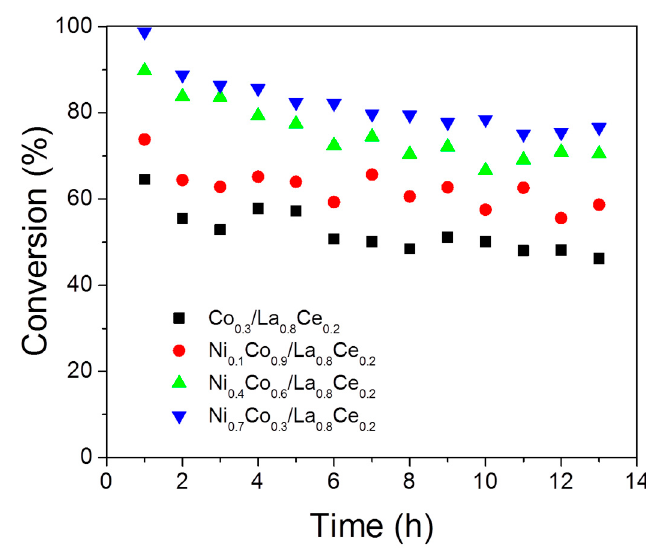
Figure 12. Stability tests in the reaction of ethanol decomposition over Ni 1-x Co x /La 0.8 Ce 0.2